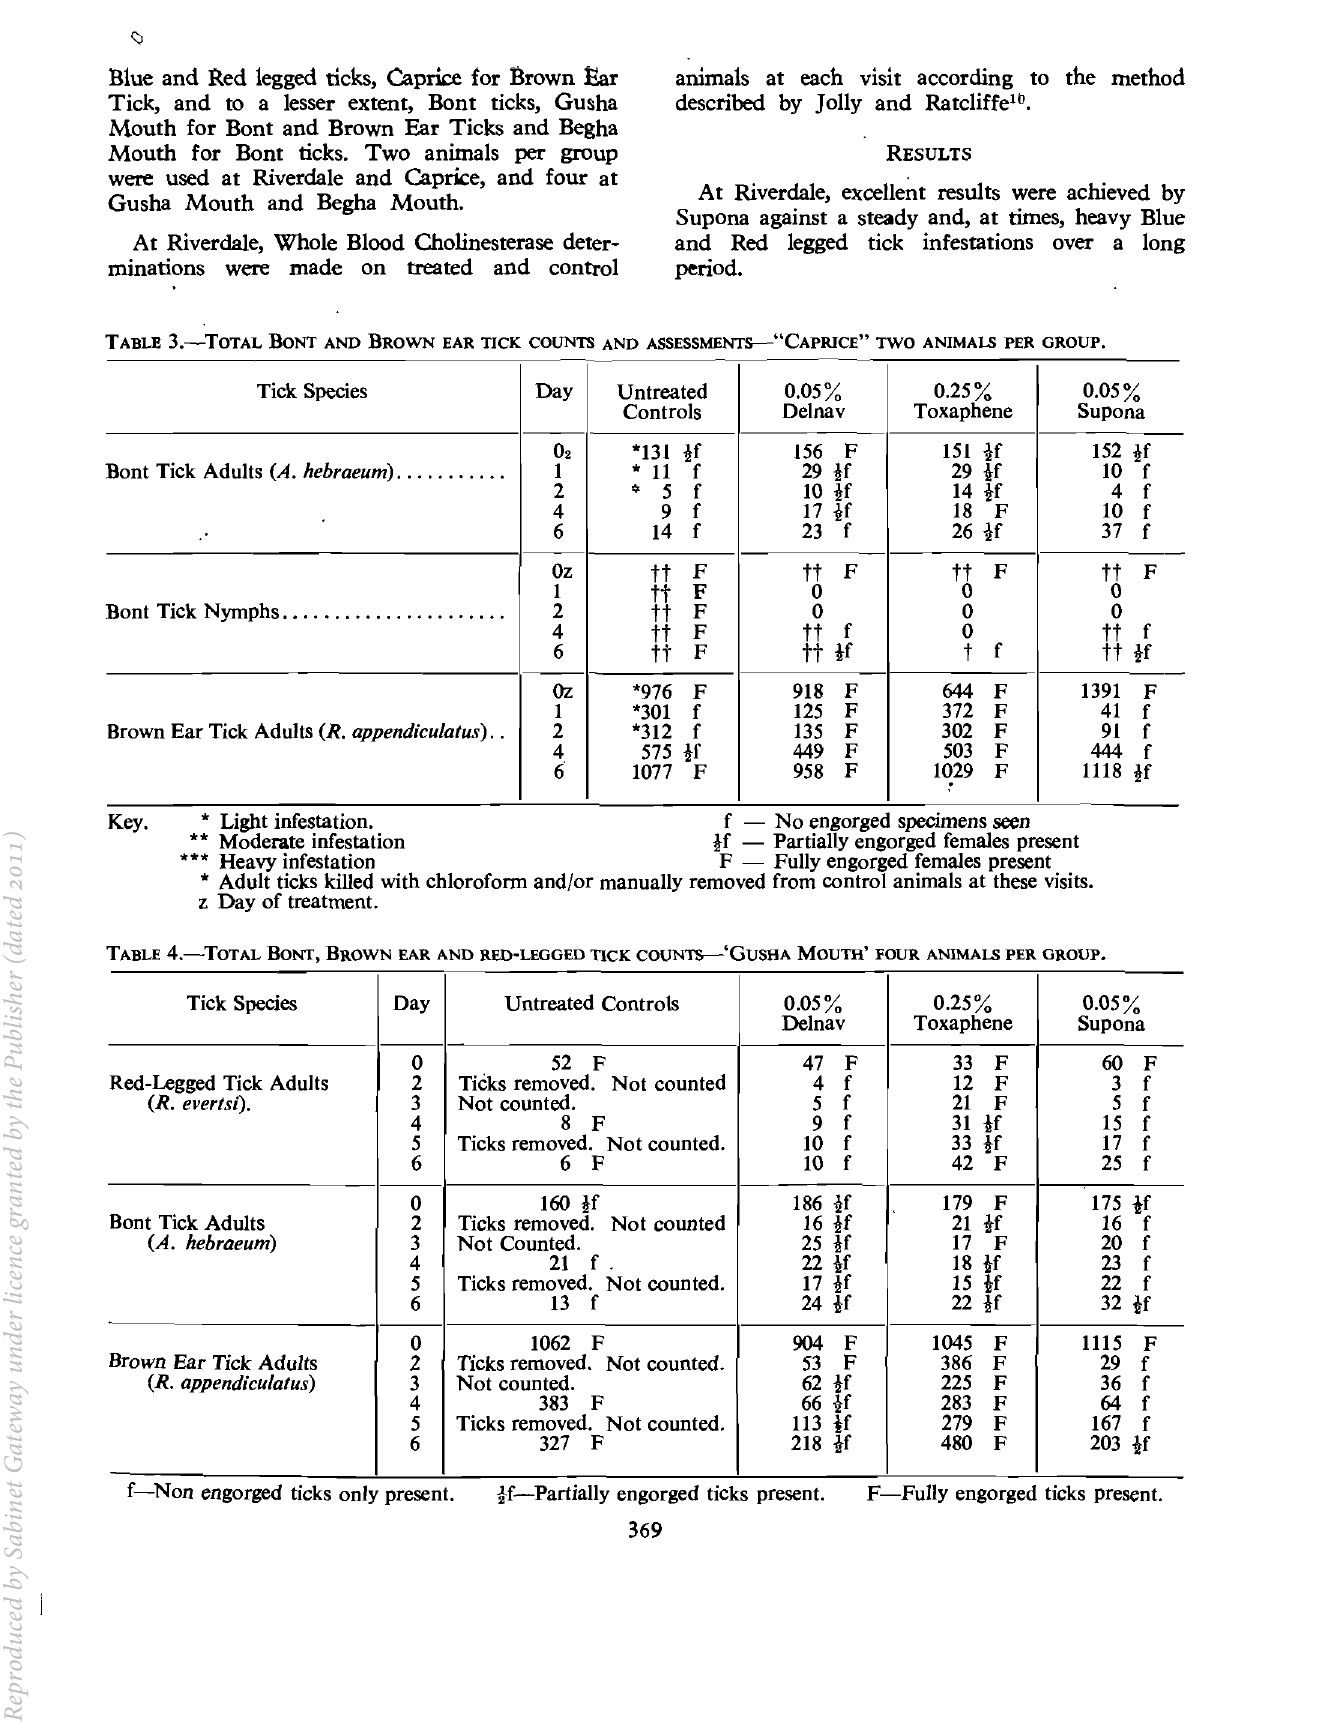
TABLE 3.-TOTAL BONT AND BROWN EAR TICK COUNTS AND ASSESSMENTS--"CAPRlCE" TWO ANIMALS PER GROUP. Tick Species